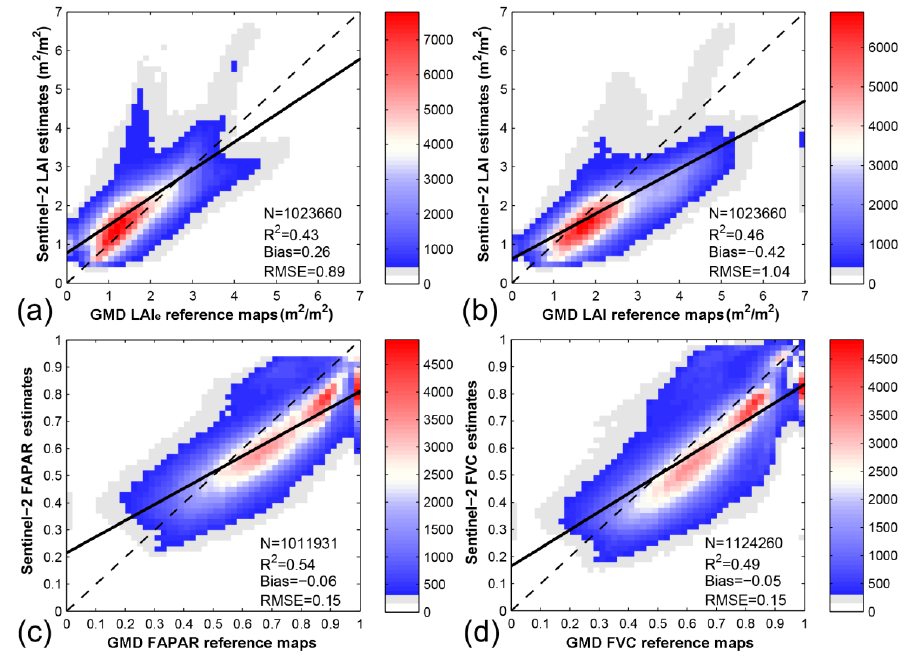
Figure 7. The biophysical-specific comparison between ground-measurements-derived (GMD) reference maps and Sentinel-2 estimates at the pixel scale from 2015 to 2016. The solid black and dash black lines represent the linear fit for all pixels and 1:1 line, respectively. The colorbar shows the density of pixels falling at each grid. ( a ) – ( d ) stand for LAI e , LAI, FAPAR, and FVC comparison, respectively.